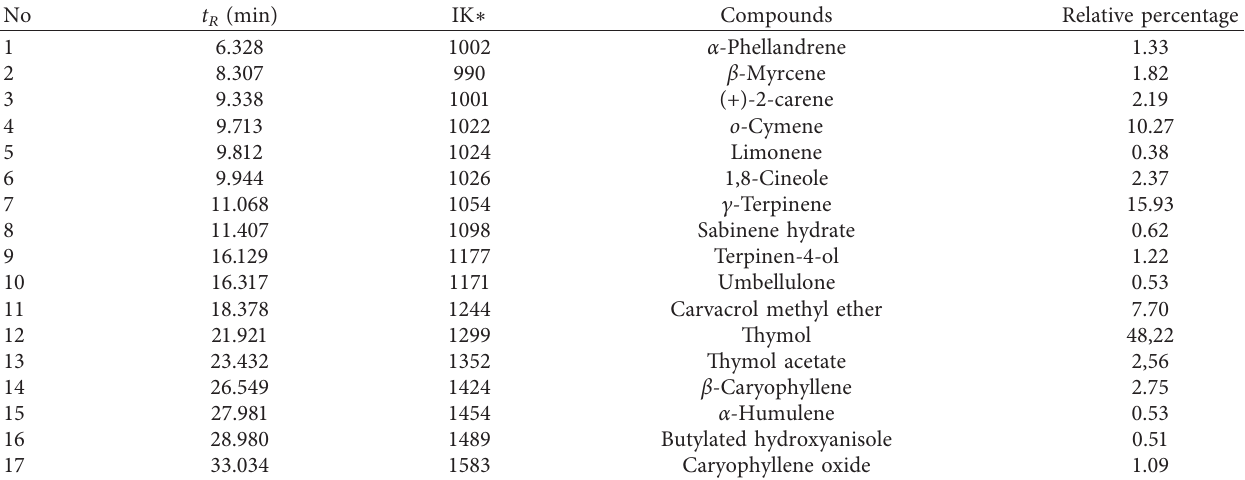
Table 1: Substances identified in GC-MS analysis of T. procumbens essential oil.